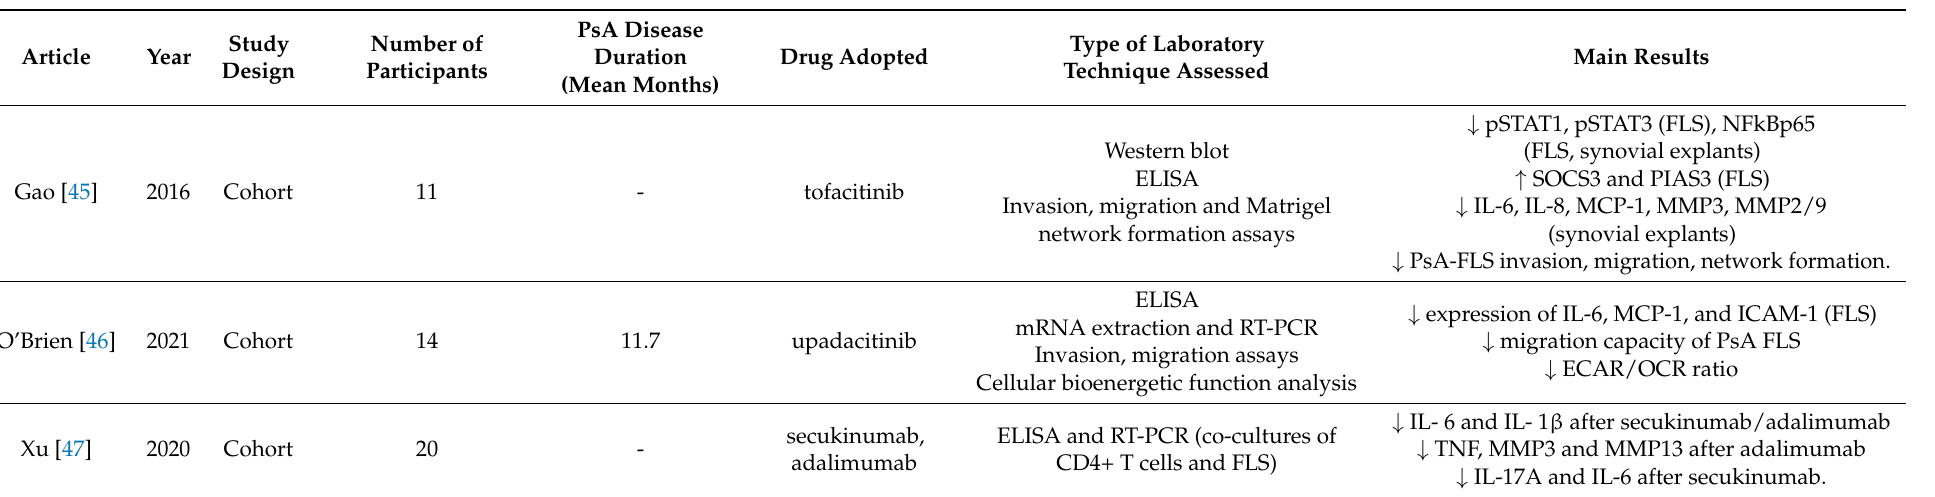
Table 3. Summary of Evidence (in vitro